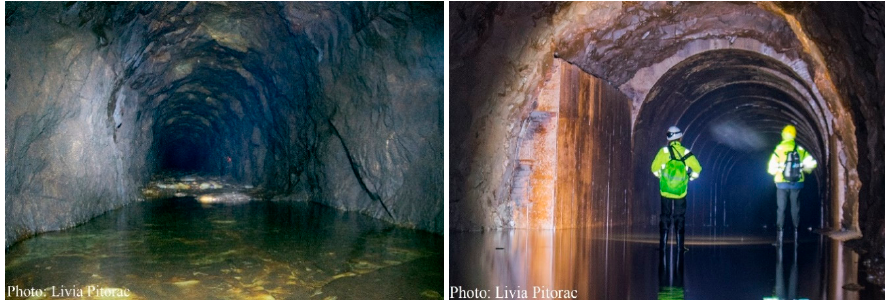
Figure 3. Example of typical Norwegian PSP layout.